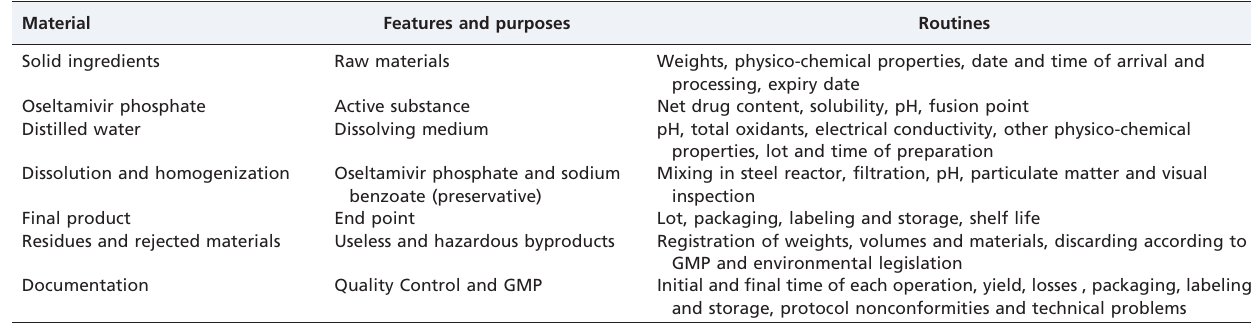
Table 3 - Manufacturing flowchart.